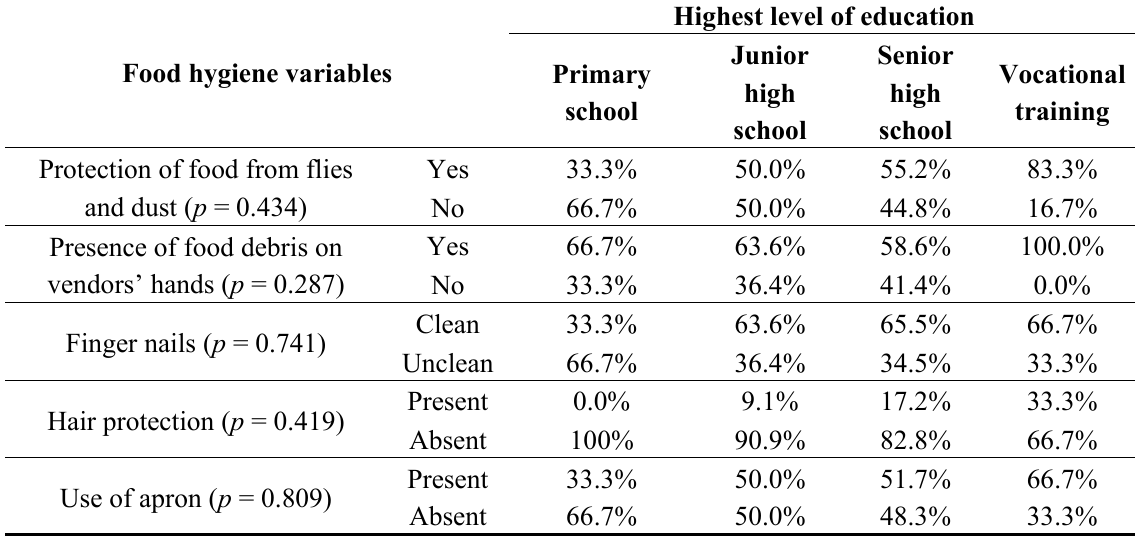
Table 5. Relationship between vendors’ educational level and food hygiene variables.